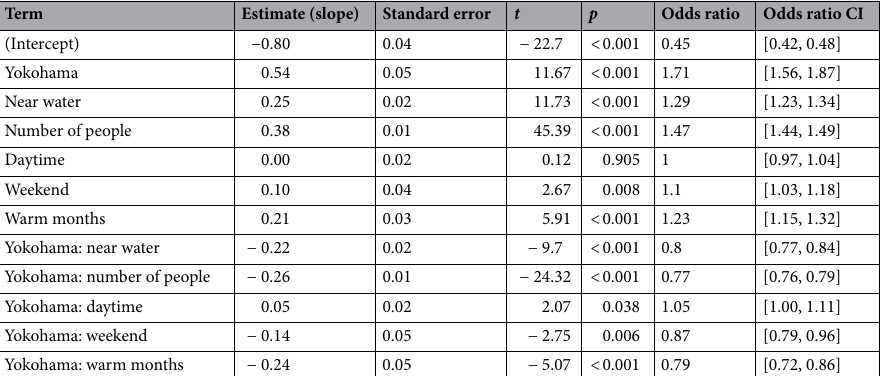
Table 4. The association of distance from water bodies with